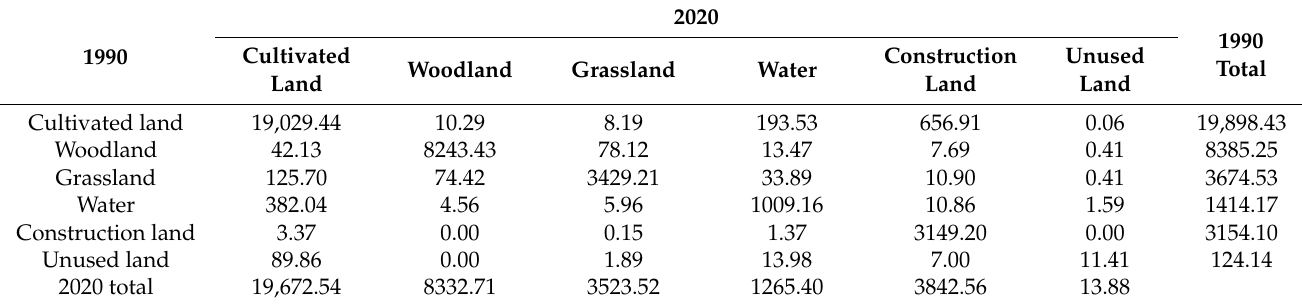
Table 7. Land Use Transfer Matrix of the Yellow River Basin (Henan Section) from 1990 to 2020 (km 2